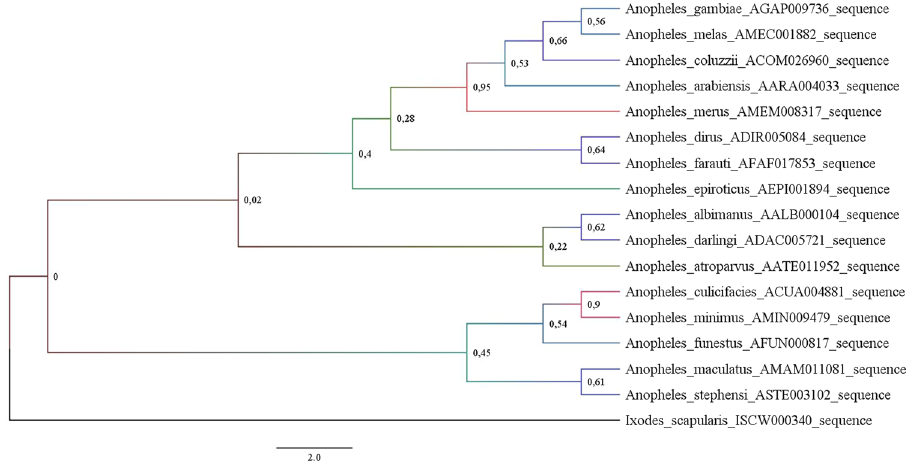
Figure 4. NDAE1 molecular phylogenetic analysis by Maximum Likelihood method. Using the Maximum Likelihood method based on the best fitted models (LG + G), the tree with the highest log likelihood ( − 4016.814) is shown. A Gamma distribution (G) was used to model evolutionary rate differences among sites (5 categories ( + G, parameter = 0.27). The tree is drawn to scale, with branch lengths measured in the number of substitutions per site. The analysis involved 17 amino acid sequences with respective NCBI accession number: A. albimanus (AALB000104); A. arabiensis (AARA004033); A. atroparvus (AATE011952); A. coluzzii (ACOM026960); A. culicifacies (ACUA004881); A. darlingi (ADAC005721); A. dirus (ADIR005084); A. epiroticus (AEPI001894); A. farauti (AFAF017853); A. funestus (AFUN000817); A. gambiae (AGAP009736); A. maculatus (AMAM011081); A. melas (AMEC001882); A. merus (AMEM008317); A. minimus (AMIN009479); A. stephensi (ASTE003102) and Ixodes scapularis (ISCW000340) (outgroup). All positions containing gaps and missing data were eliminated and bootstrap values for internal branches are